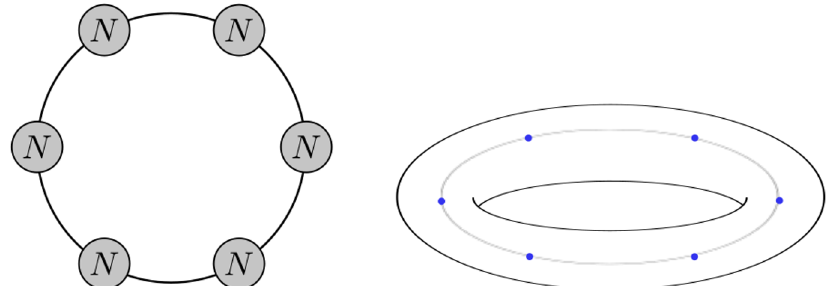
Figure 1 . Left: quiver representation for the ˆ A K − 1 necklace theory, with each node corresponding to a N = 2 vector multiplet and each line a hypermultiplet in the bifundamental of the adjacent groups. Right: the torus with K minimal punctures, T 2 , of the associated class S K